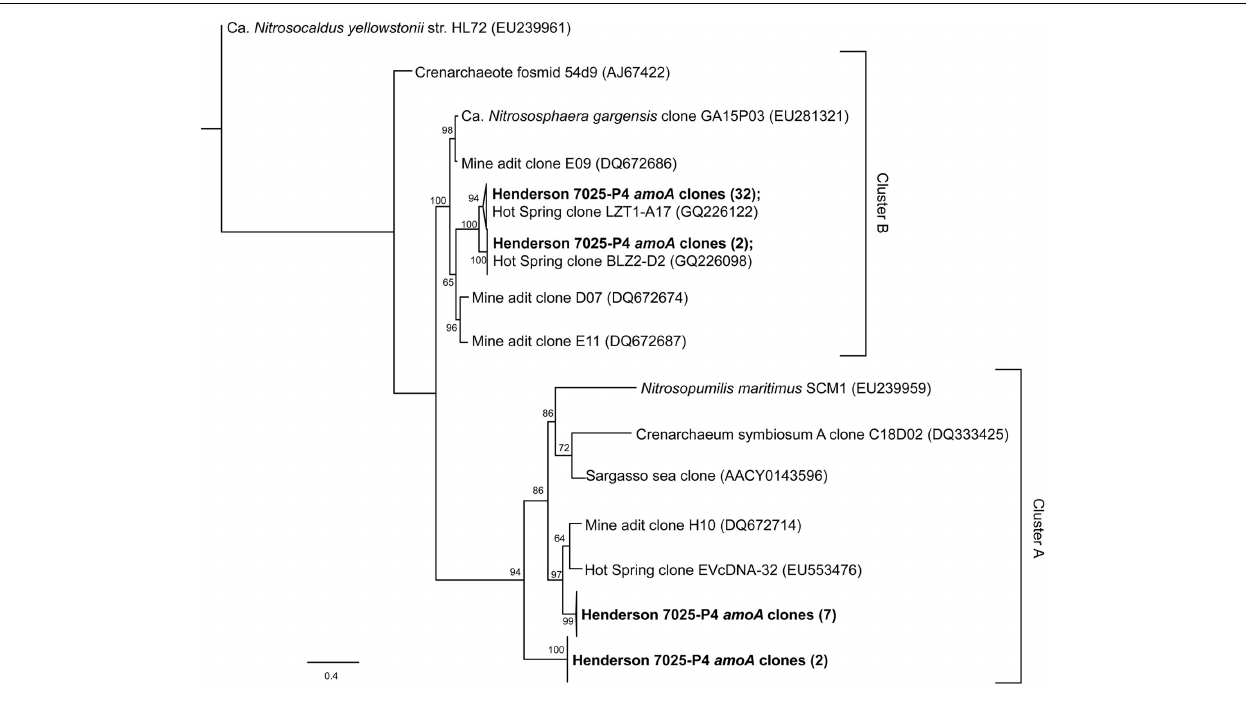
phylotypes from this study fall into four distinct sub-clusters within the previously defined A and B clusters (Beman and Francis, 2006; Zhang et al., 2008).The bacterial amoA outgroup has been removed for visual clarity.The scale represents 0.4 substitutions per site.